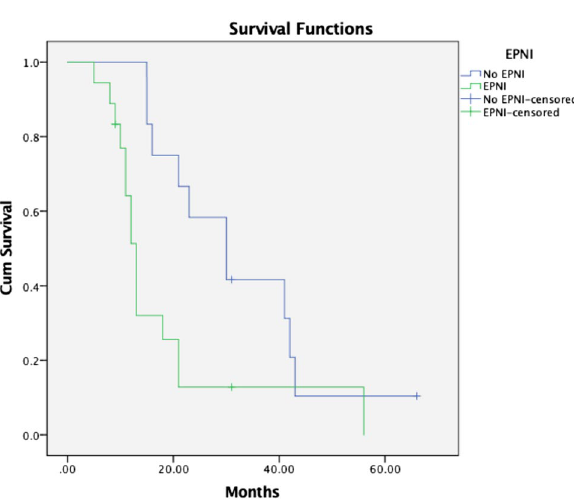
Figure 6. Patient with histologically confirmed pT1c, pN1 (1/14), L0, V0, R0 G2 tumor with positive perineural invasion in the dorsal area of resection. ( A , B ) Both axial images in the arterial phase. Origin of IPDA arising from SMA with subtle diffuse infiltration along the IPDA and in the peripancreatic tissue (arrows), reported as Pattern 2 by the first observer and negative by the second observer. ( C ) First postoperative CT study within 3 months after resection showing areas of focal increased attenuation left to SMA (arrow). ( D ) Second postoperative study within 5 months after resection (MRI was performed to verify unclear liver finding within the previous CT study). Focal area of soft tissue intensity and enhancement (arrow) has increased in size and was interpreted as local recurrence.